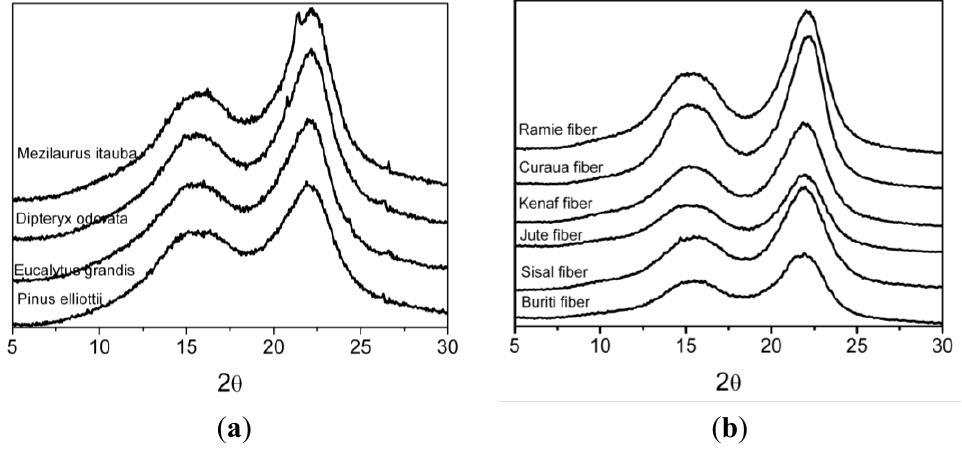
Figure 2. X-ray diffractograms of ( a ) wood species and ( b ).vegetal fibers